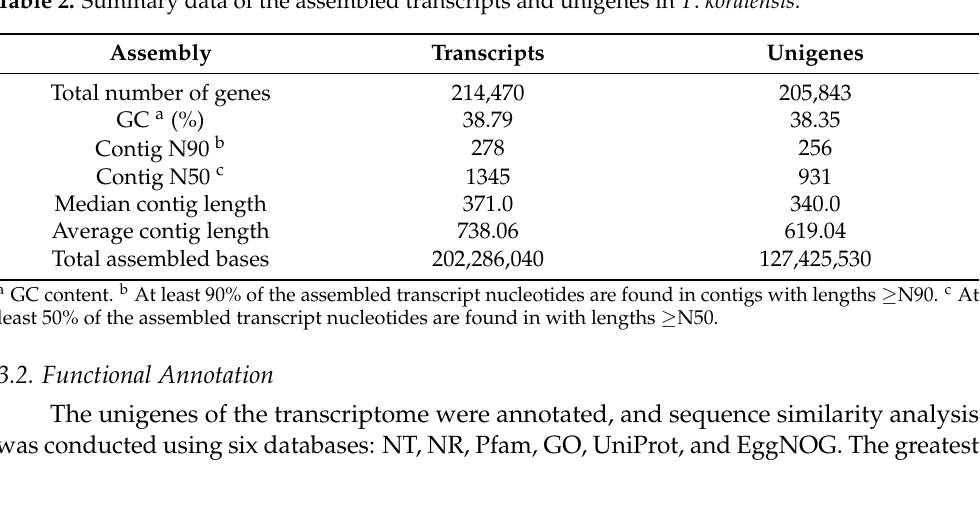
Table 2. Summary data of the assembled transcripts and unigenes in T . koraiensis